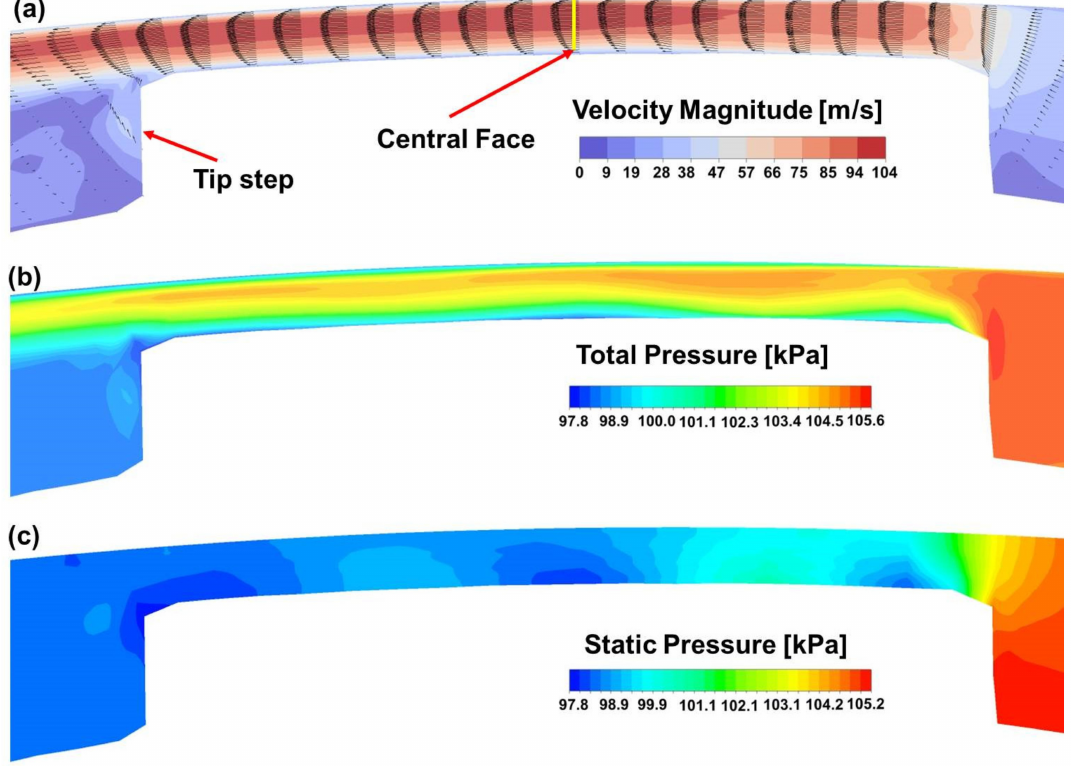
Figure 14. The velocity and pressure distribution in the tip gap at the crank angle of 43 ◦ under the pressure ratio of 1.072: ( a ) velocity field, ( b ) Total pressure, ( c ) Static